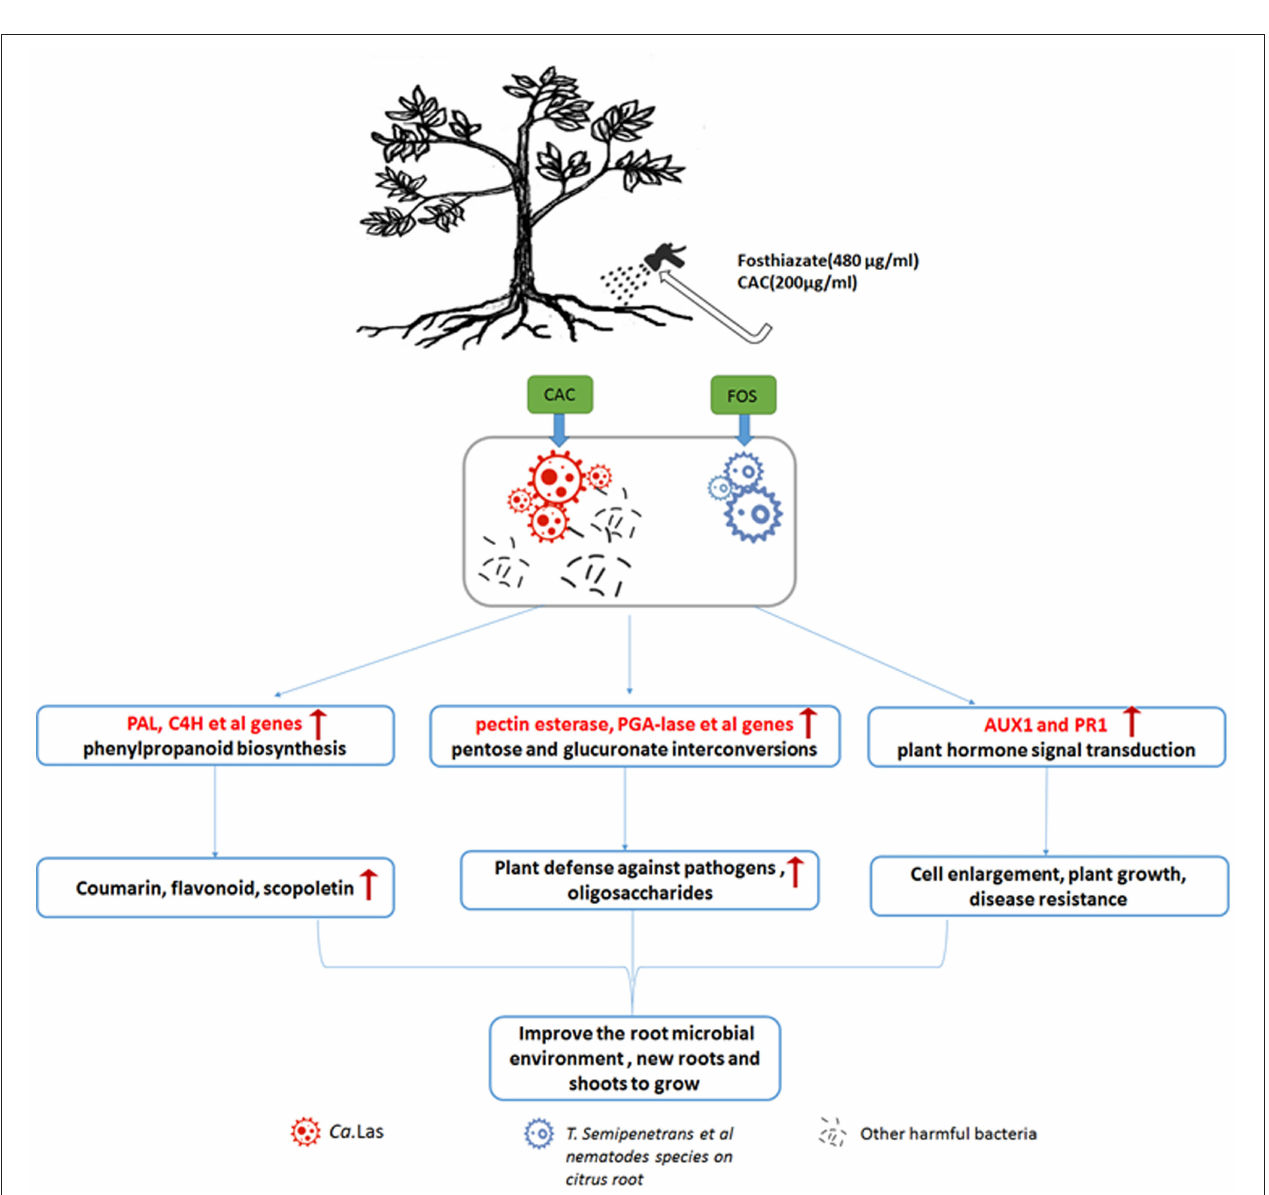
FIGURE 8 | Schematic diagram of treatment method FOS and CAC combination through root drenches and a possible treatment mechanism. Our treatment plan is that for every sunny day, 480 µ g/mL of FOS are provided to the HLB-infected citrus roots evenly through root drenches (pesticide FOS may eliminate T. semipenetrans and other nematodes on citrus root). After 3 days, the same roots are treated with 200 µ g/mL of pesticide CAC (not only kill bacteria but also promote the greening of plant leaves) in a framework of correct orchard management. During this treatment, phenlypropanoid biosynthesis and pentose and glucuronate interconversion are promoted, resulting in the production of secondary metabolites, enhanced plant growth, induction of resistance, and differentiation of new roots and shoots. As a consequence, HLB-infected trees will improve their health condition, and the population of rhizosphere and endophytic pathogens will be controlled. In case of severe HLB infection, one more CAC treatment is envisaged. The treatment methods in greenhouse and the orchard are similar, but there is no need to worry about the weather, the treatment is carried out at any time, and the leaves are sprayed with CAC (same concentration as root drench).